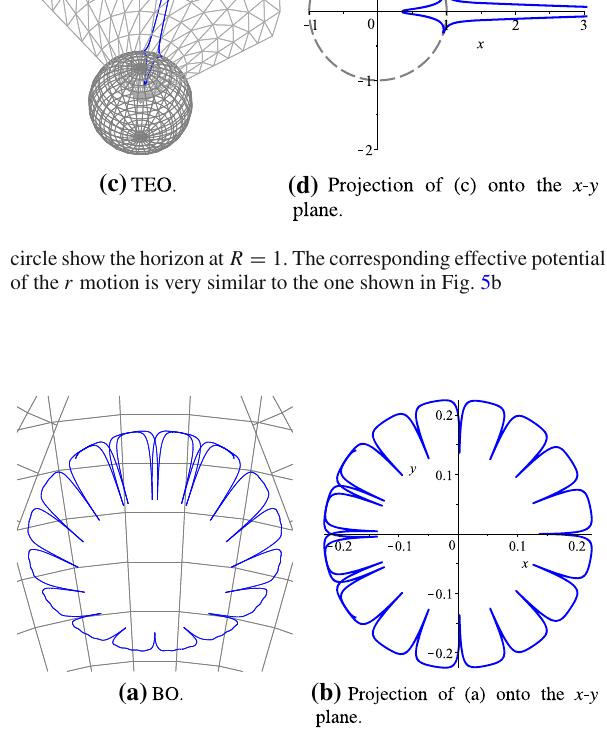
Fig. 13 BO for parameters K = 0 . 1 , L = 80 , δ = 1 , l = 1 , J = 0, and energy E = 81 . 5082984. The corresponding effective potential of the r motion is very similar to the one shown in Fig.